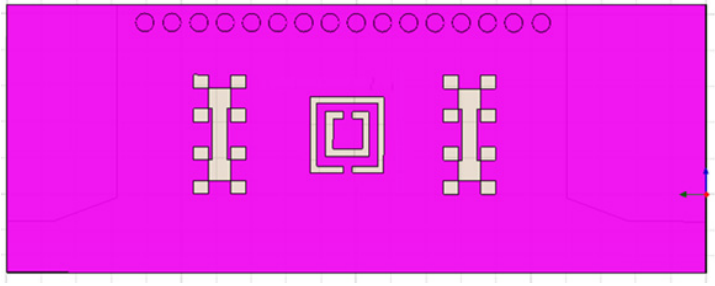
Figure 11. Bottom view of the proposed BPF with DGS and CSRR.